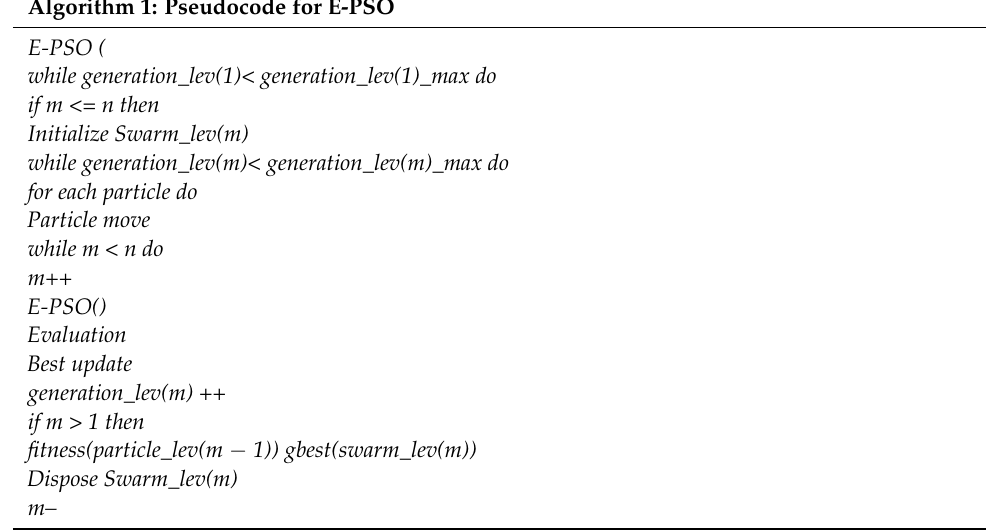
Algorithm 1: Pseudocode for